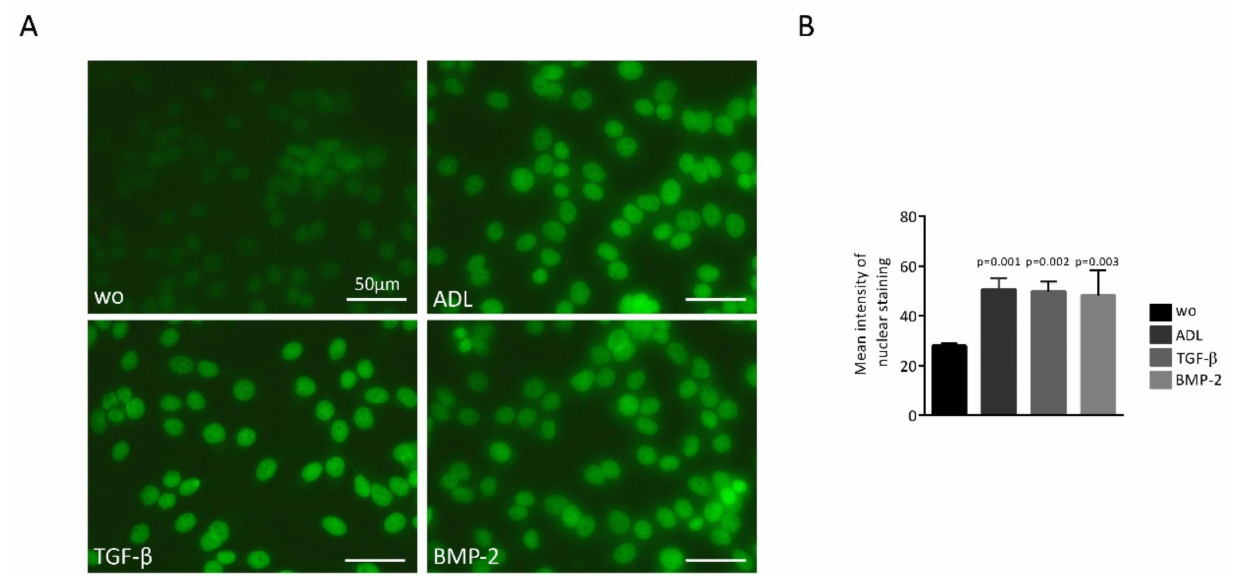
Figure 5. ADL, TGF- β , and BMP-2 increased positive staining of the nucleus for AMTN in HSC2. ( A ) Immunofluorescent staining of the nucleus for AMTN showed higher intensity in ADL, TGF- β , and BMP-2. ( B ) Comparison of mean fluorescent intensity of the nucleus by Image J software showed higher mean intensity levels in ADL, TGF- β , and BMP-2, compared to untreated control. Note: “wo” stands for without indicating unstimulated